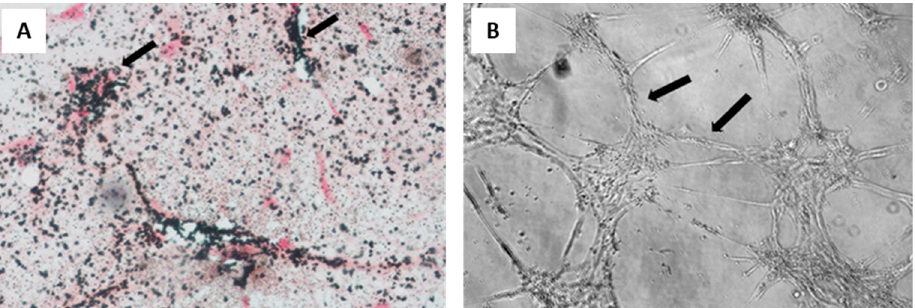
Figure 6. Osteogenic and vasculogenic potential of dental pulp MSCs: ( A ) von Kossa staining of osteo-differentiated dental pulp MSCs, showing calcium deposits in black and cells in red. Arrows point to representative areas of intense mineral deposition in proximity to osteoblasts; and ( B ) light micrograph of dental pulp MSCs after endothelial differentiation, showing capillary tube-like structures. Reprinted with permission and adapted from [61], under Elsevier and Copyright Clearance Center (license number 5166500137992).